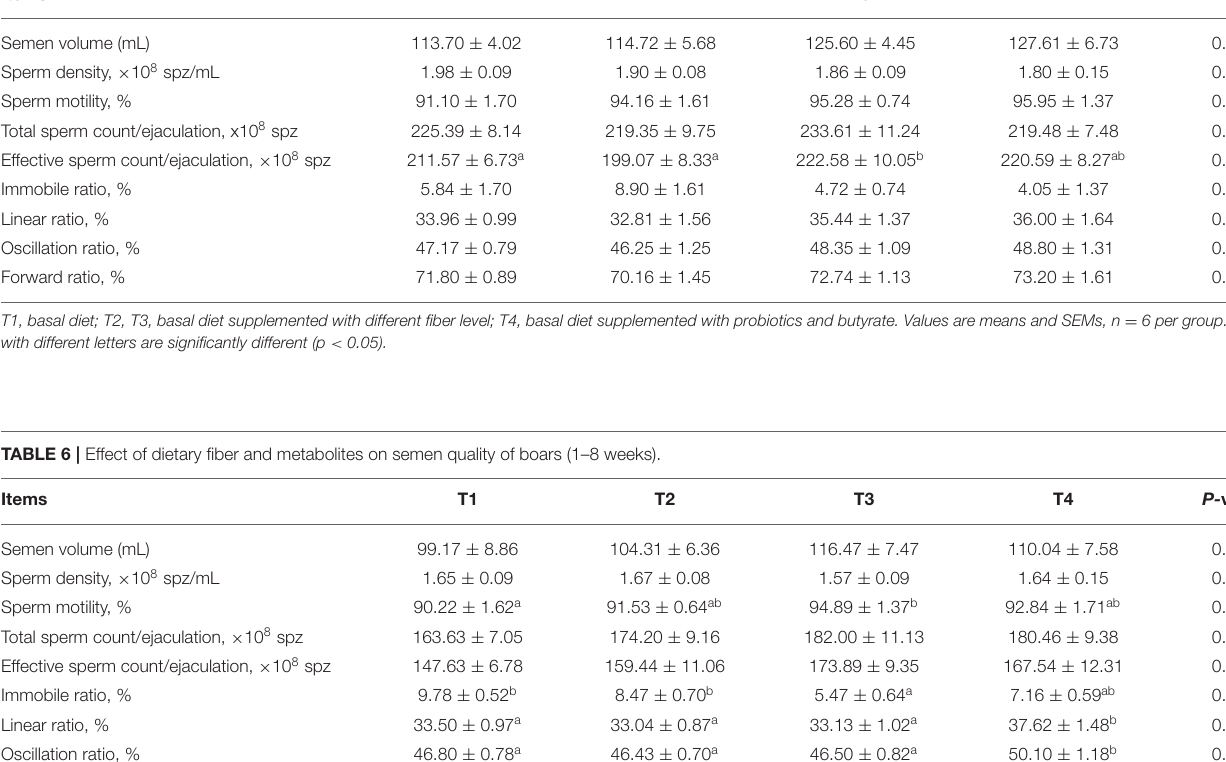
TABLE 5 | Effect of dietary fiber and metabolites on semen quality of boars (5–8 weeks). Items